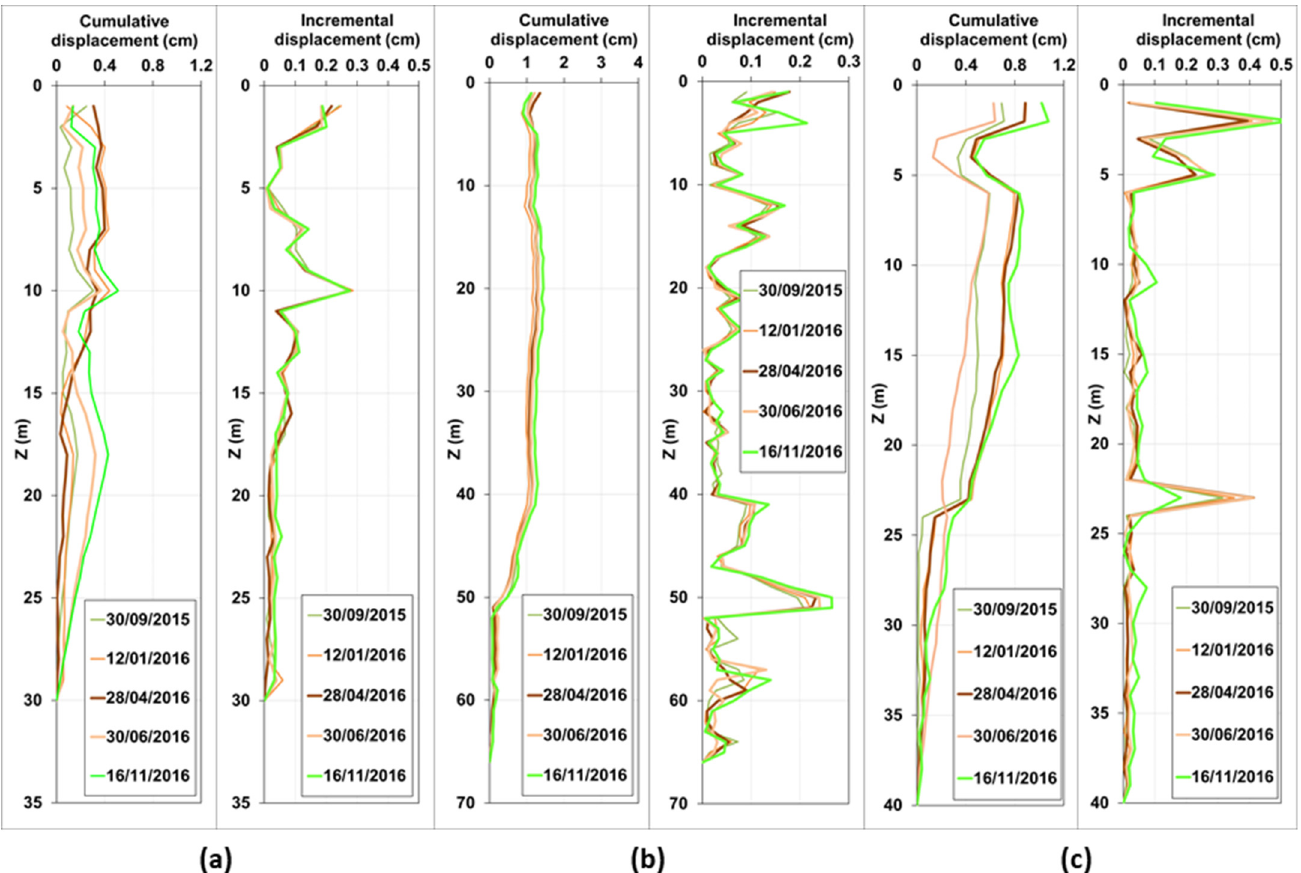
Figure 15. Post-failure inclinometer profiles for three boreholes in the landslide area: ( a ) S2, ( b ) S6, and ( c ) S8 (see Figures 1, 4 and 13 for location).